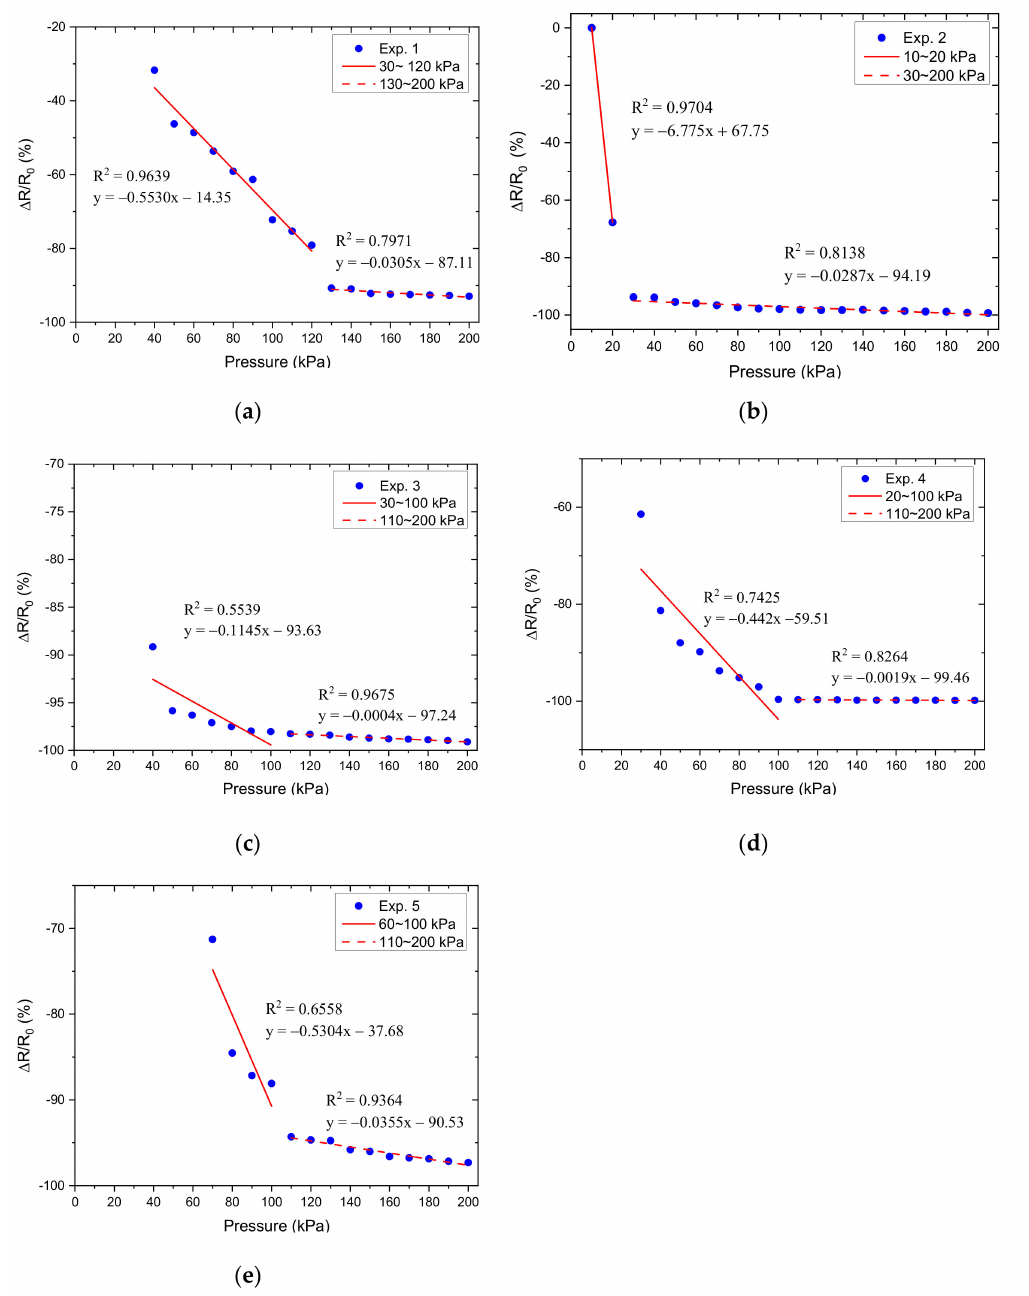
Figure 18. The relative resistance change as a function of applied pressure for different grid microstructures in which ( a – e ) corresponds to experiments